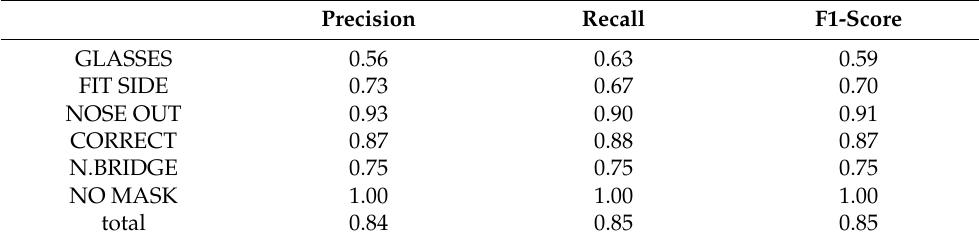
Table 4. Classification results for VGG16 model in the validation